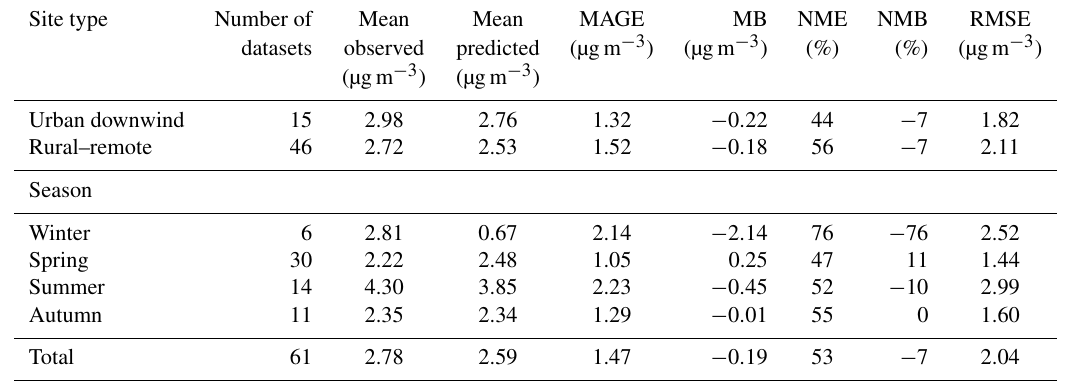
Table 2. Statistical evaluation of EMAC SOA against AMS OOA from 61 datasets worldwide during 2001–2010. Site